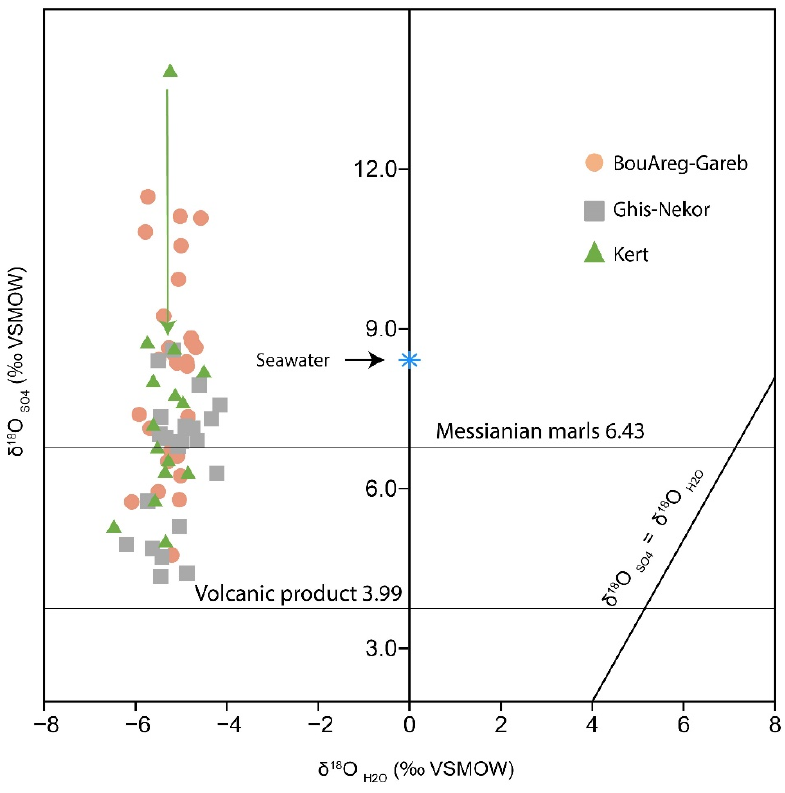
Figure 6. Oxygen isotope compositions of the dissolved sulfate species ( δ 18 O SO4 versus) relative to those of groundwater (δ 18 O H2O ) from which the sulfate was extracted seawater data from [ 37], O-O line from [ 38].